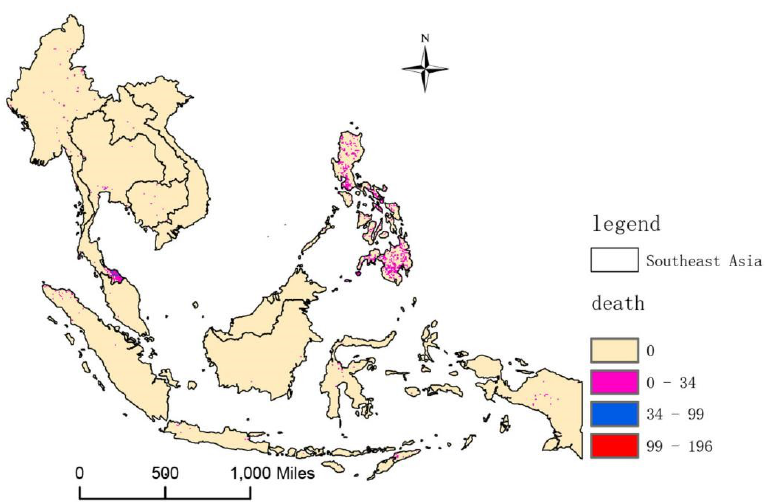
Figure 2. Southeast Asia terrorist attack death map.